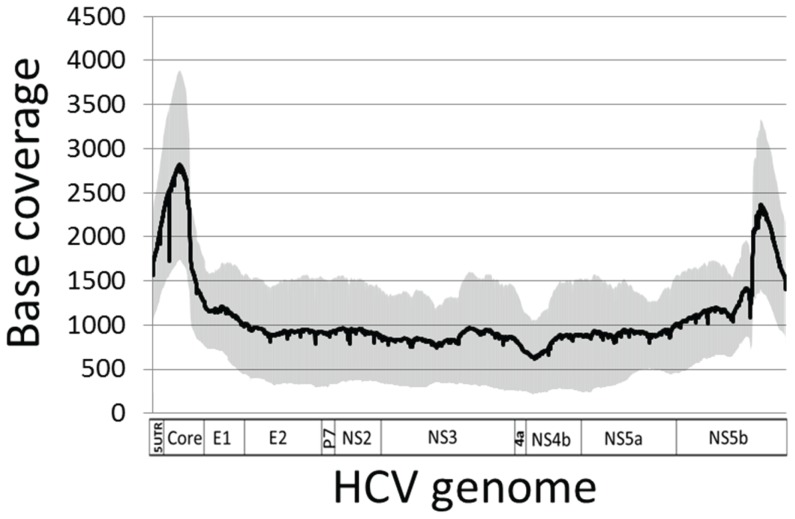
Average base coverage over 9022-bp amplicon after read quality control.The amplicon covers 96% HCV genome from 5′UTR to NS5b as indicated at the bottom. Grey area represented standard derivation of the base coverage at each HCV genomic position.